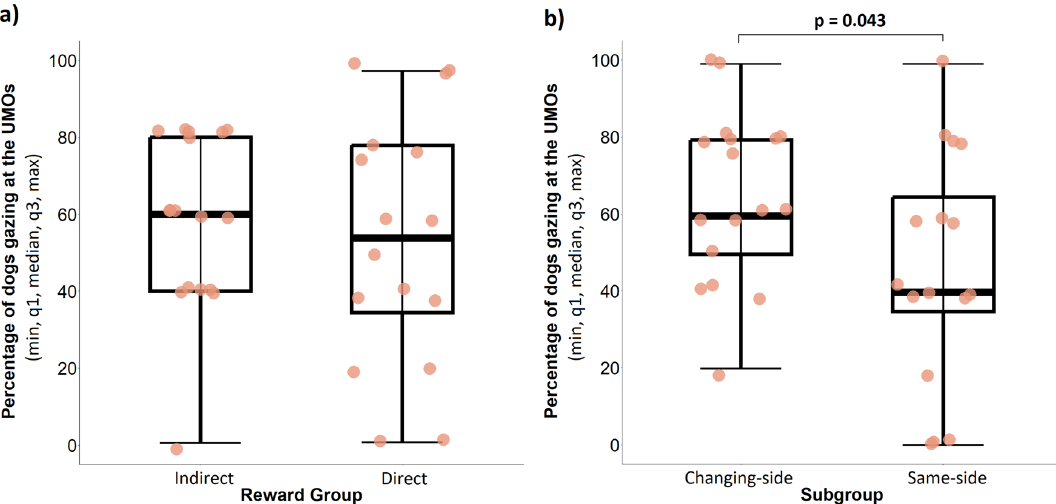
Figure 4. Effect of ( a ) Reward groups and ( b ) Location subgroups on the likelihood of dogs gazing at a UMO before release in the Test phase. The p -value indicates the difference between the Location subgroups. For the Reward groups, no post-hoc analysis was conducted because it did not have a significant effect in the model. Overall, dogs were not more likely to direct their first gaze at the familiar UMO instead of the unfamiliar one before (Wilcoxon signed rank test: N = 33, z = − 0.68, P = 0.499) or after release ( N = 33, z = − 1.36, P = 0.174) in the Test phase. Likewise, there was also no preference towards either of the UMOs in the reward groups and location subgroup before release (DRG: N = 16, z = − 0.92, P = 0.356; IRG: N = 17, z = − 0.17, P = 0.862; Same-side: N = 16, z = − 0.94, P = 0.345; Changing-side: N = 17, z = − 0.05, P = 0.958). We also did not find a preference of gazing at one of the UMOs first after release in either of the reward groups (DRG: N = 16, z = − 0.03, P = 0.977; IRG: N = 17, z = − 1.84, P = 0.065; Fig. 5a) or location subgroups (Same-side subgroup: N = 16, z = − 1.76, P = 0.078; Changing-side subgroup: N = 17, z = − 0.31, P = 0.755; Fig. 5b). Gaze alternation between the UMO and the cage. Familiarization phase. In the Familiarization 2 phase, the reward group had an effect on the frequency of gaze alternation (GLMM, LRT: χ 1 = 4.91, P = 0.003) with dogs in the IRG alternating their gaze between the UMO and the cage significantly more often than subjects in the DRG (IRG vs. DRG: β ± SE = 0.10 ± 0.04, P = 0.017) (Fig. 6). Whether the UMO started from the same side or switched sides continuously, or which UMO was used as the familiar one did not have an effect (Location 2 2 subgroup: χ 1 = 0.04, P = 0.531; Familiar UMO: χ 1 = 0.39, P = 0.531). In addition, there was a marginal difference